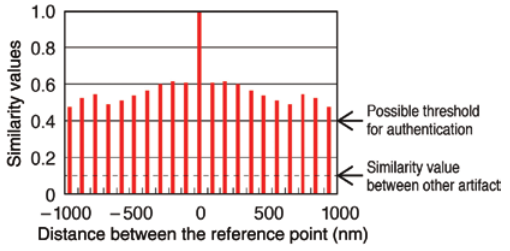
Figure 10: Similarity values between the retrieved result at the reference point and other points in artifact 1. Source: Adapted with permission from Springer-Verlag: Appl. Phys. A [46].